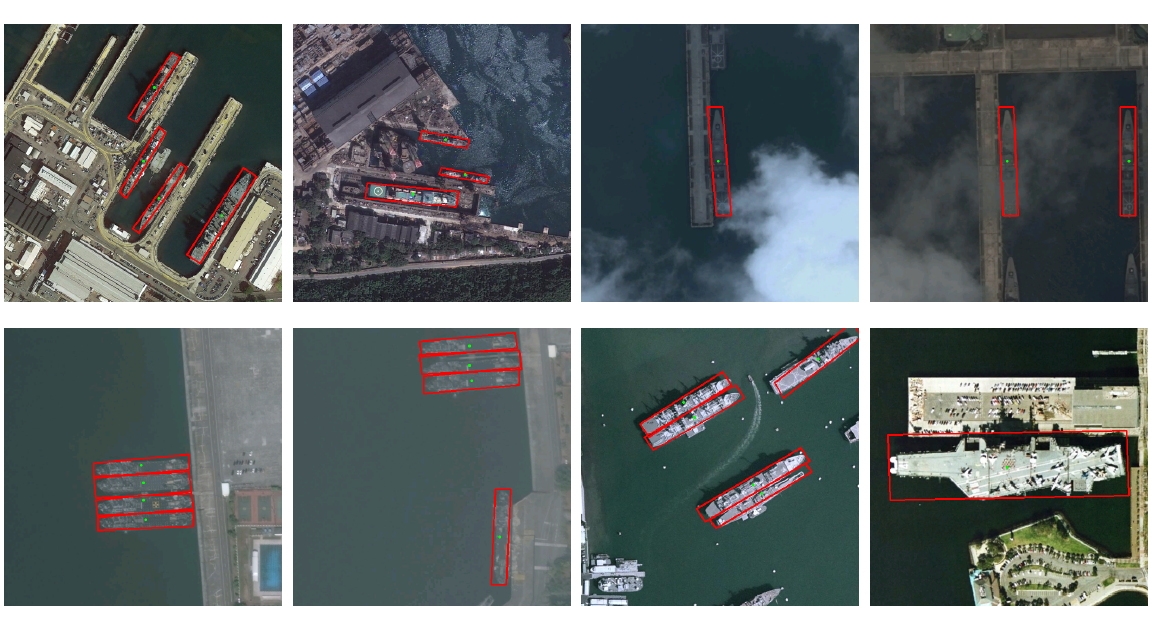
Figure 6. Examples of the ship detection results by our method in the form of the rotated bounding boxes. We note that the small ships are not taken into consideration on our two datasets.